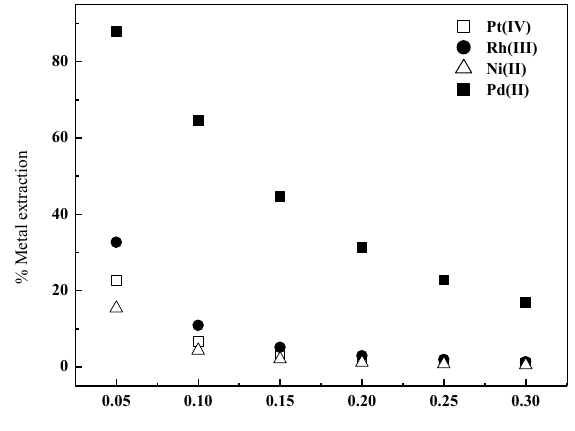
Figure 7 . Separation studies of Pd(II) from acidic chloride solutions of Pt(IV), Ni(II) and Rh(III) as a function of the H + concentration using HPBI as extractant. [M] = 1.12 × 10 -4 mol L -1 at 0.05 mol L -1 H + with 1.0 mol L -1 Cl - , [HPBI] = 1.0 × 10 -3 mol L -1 in CHCl